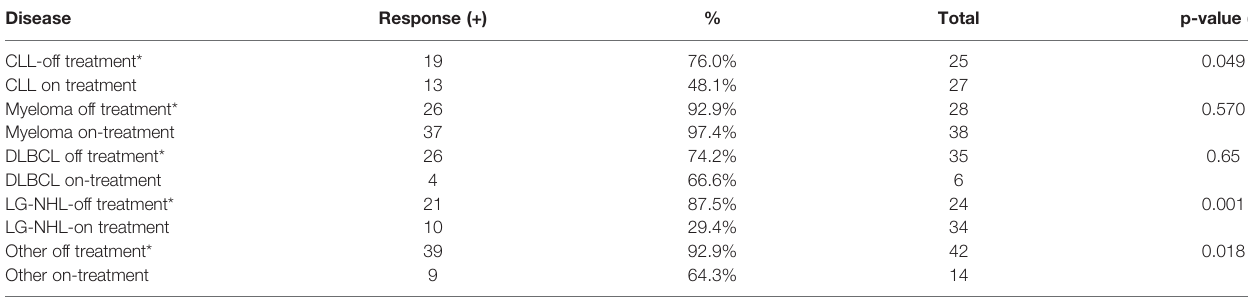
TABLE 3 | The COVID-19 response rate by disease group on/off treatment.